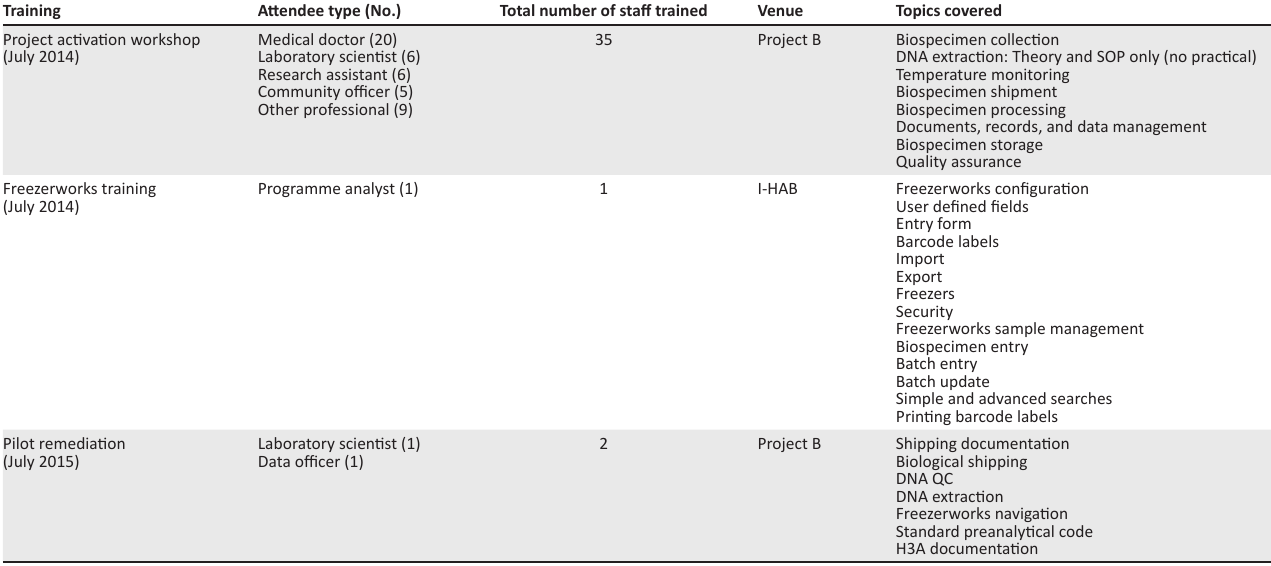
TABLE 3: Training topics to build knowledge & skills – Project B in Nigeria † . Training Attendee type (No.)